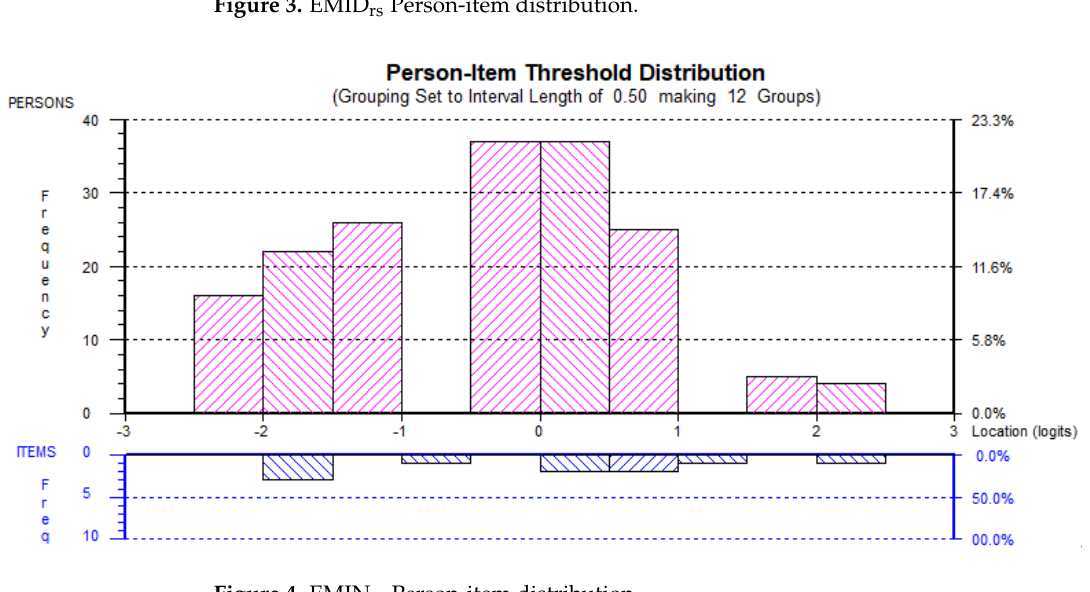
Figure 4. EMIN rs Person-item distribution.